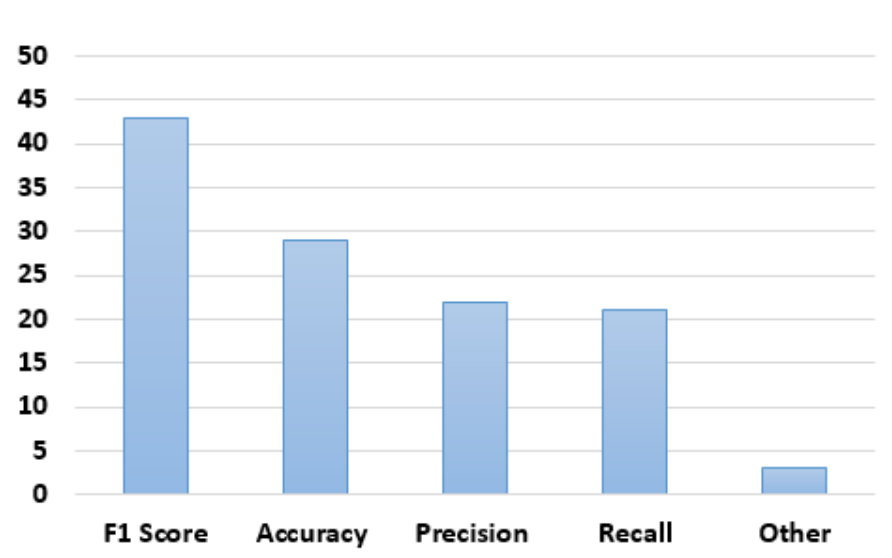
Figure 5. Performance measures.